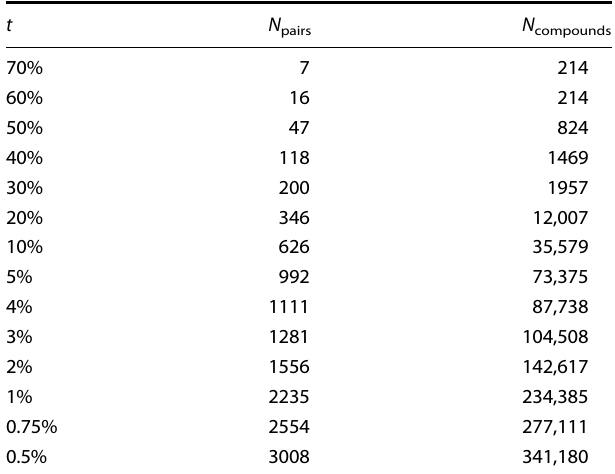
Table 3. The number of substitution pairs ( N pairs ) and the quantity of resulting compounds ( N compounds ) as a function of the threshold ( t ), starting from the initial set of 9524 compounds.